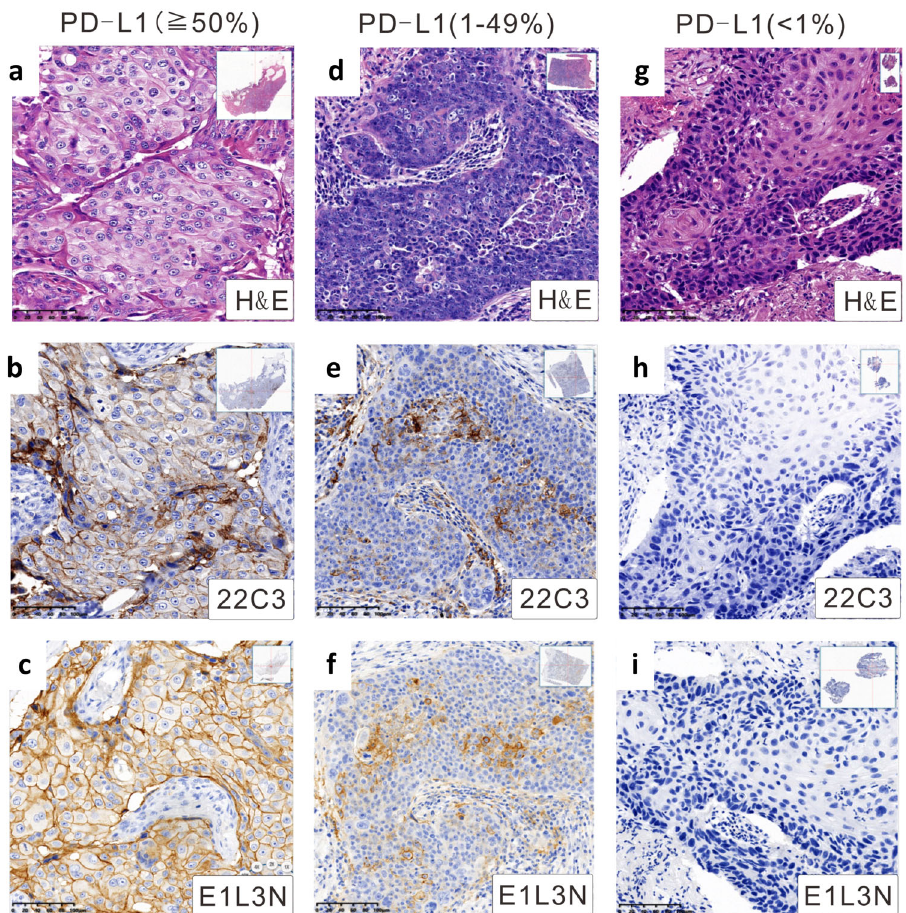
Fig. 2 Representative micrographs for PD-L1 tumor proportion score (TPS). Representative micrographs for PD-L1 tumor proportion score (TPS) of ≥ 50% ( a – c ), 1 – 49% ( d – f ), and <1% ( g – i ). a , d , and g show the hematoxylin-eosin-stained slides. b , e , and h show the 22C3-stained slides. c , f , and i show the E1L3N-stained slides. Abbreviations: H&E hematoxylin-eosin; TPS tumor proportion